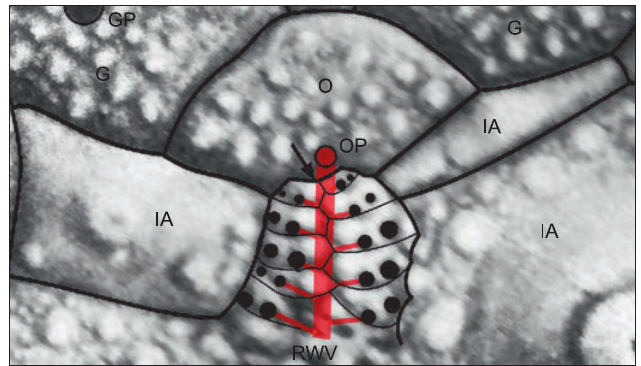
Fig. 3. Subterminal branching of the radial water vessel in a Recent cidarid echinoid Eucidaris metularia (Lamarck, 1816). Black arrow indicates the point where the next branch of the radial water vessel would arise, whereas the tip of the radial water vessel emerges through the ocular pore. Thus, although ambulacral and interambulacral plates are added to the corona terminally, branches of the radial water vessel to the tube feet are subtermi- nal. G, genital plate; GP, genital pore; IA, interambulacral plate; O, ocular plate; OP, ocular pore; RWV, radial water vessel (internal).